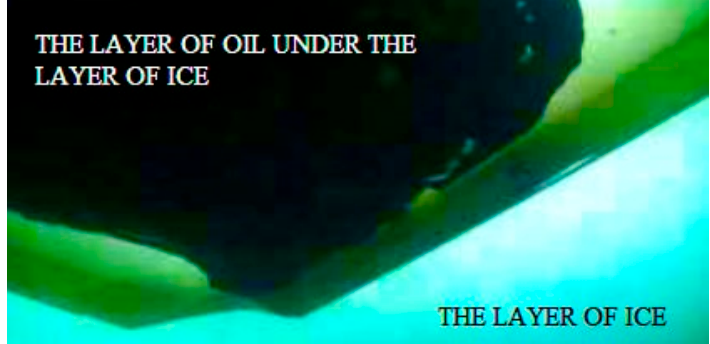
Figure 9. Image of oil below the layer of ice (looking from below) [66].